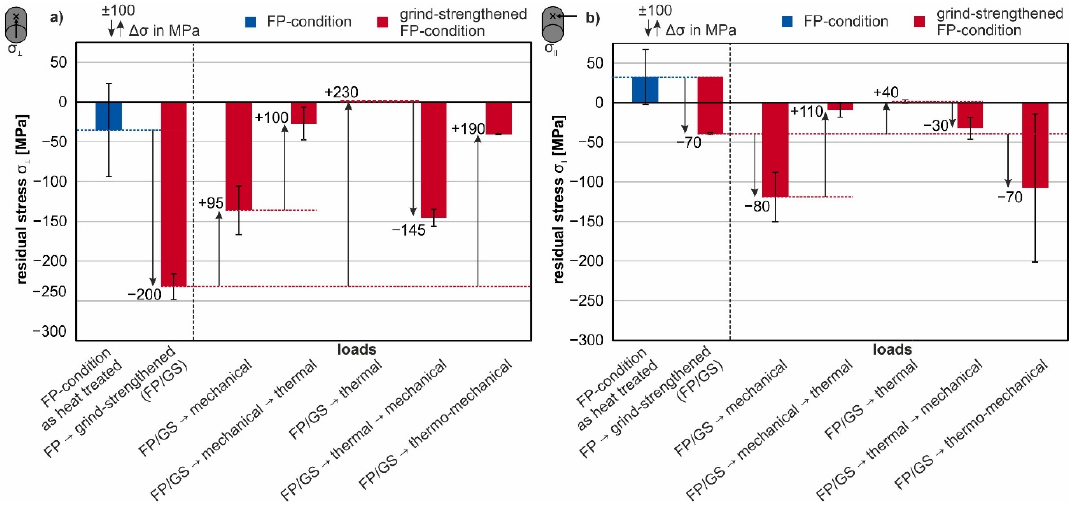
Figure 9. Surface residual stresses after grind-strengthening and various loads for the material in FP-condition ( a ) transverse to grinding direction ( b ) parallel to grinding direction.